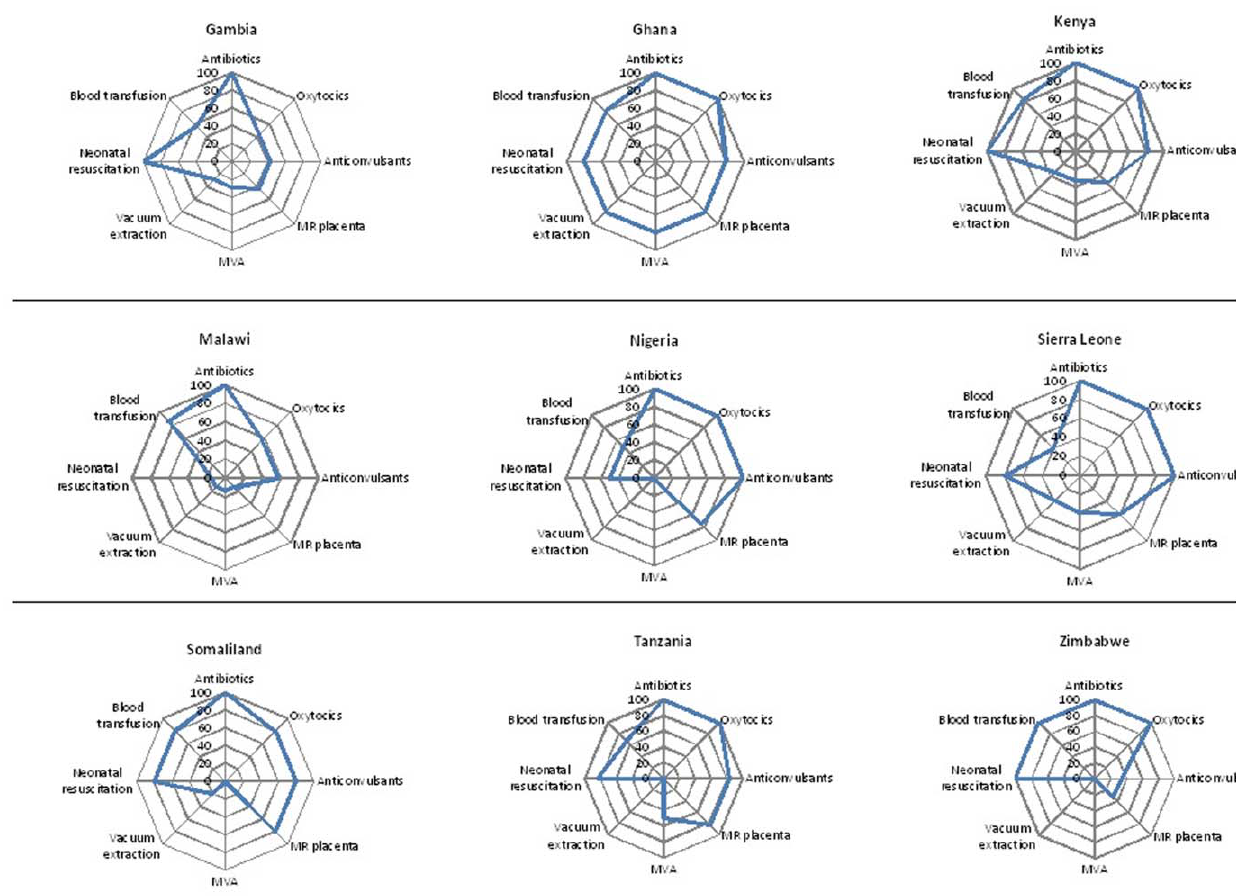
Figure 1. Percentage of different types of cadres of Nurses/Midwives who perform each of the eight signal function by country.